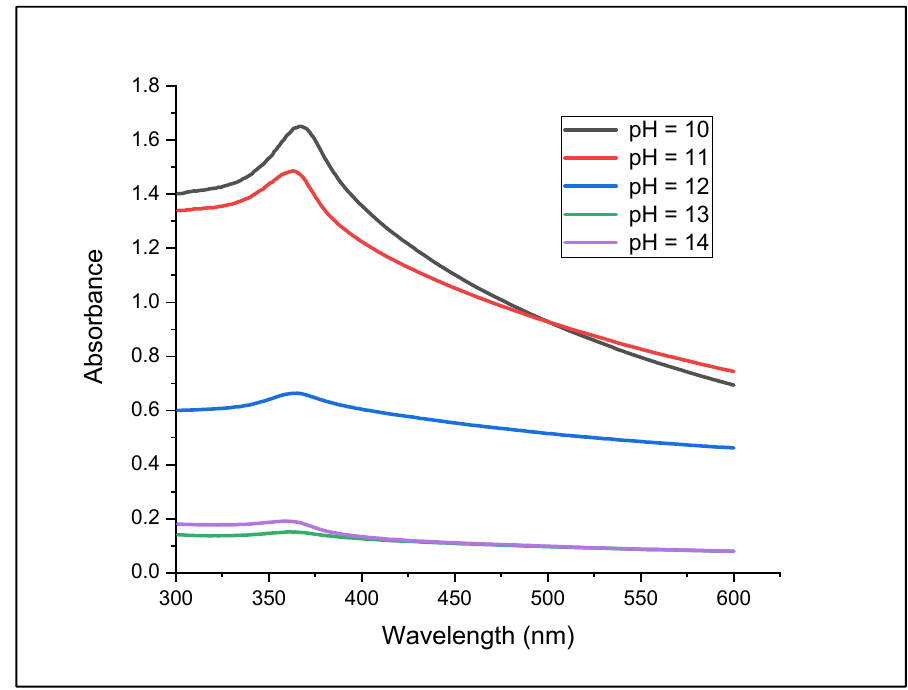
Figure 3. UV-Vis Spectra showing the e ffect of pH on ZnO nanoparticle synthesis.